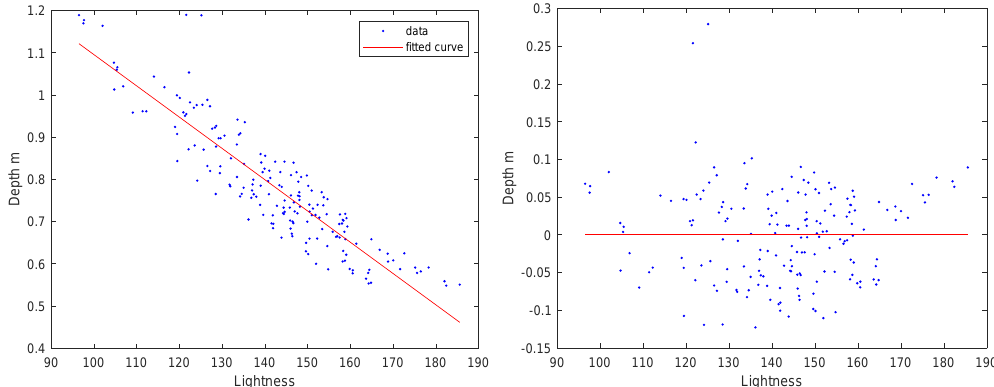
Figure 8. Lightness vs. true depth relationship for a subset of matched points (the same as that used in Figure 7). Left : local average pixel lightness vs. true depth (10 cm baseline); the red line represents the lightness to depth transformation—it is deduced from Equation (2). Right : the residuals of the depth estimation from lightness vs. true